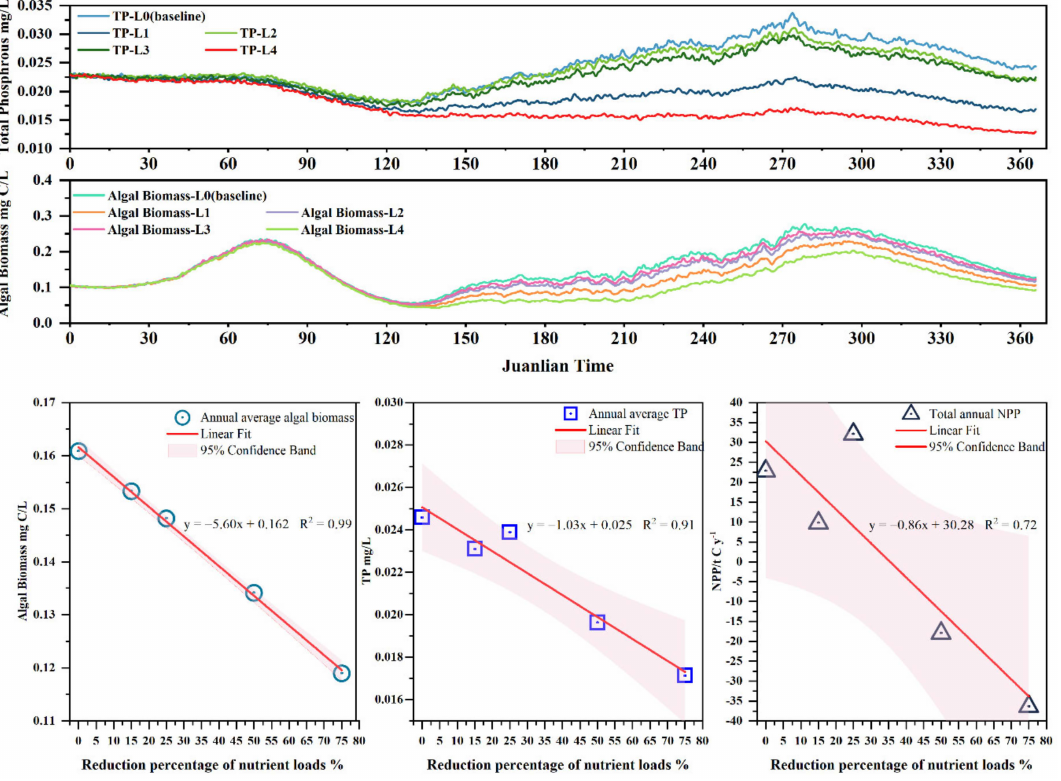
Figure 7. ( a ) Time plot of average algal biomass concentration and TP concentration in Lake Erhai under different reduction scenarios; ( b ) load reduction curve for average algal biomass, average TP concentration and annual